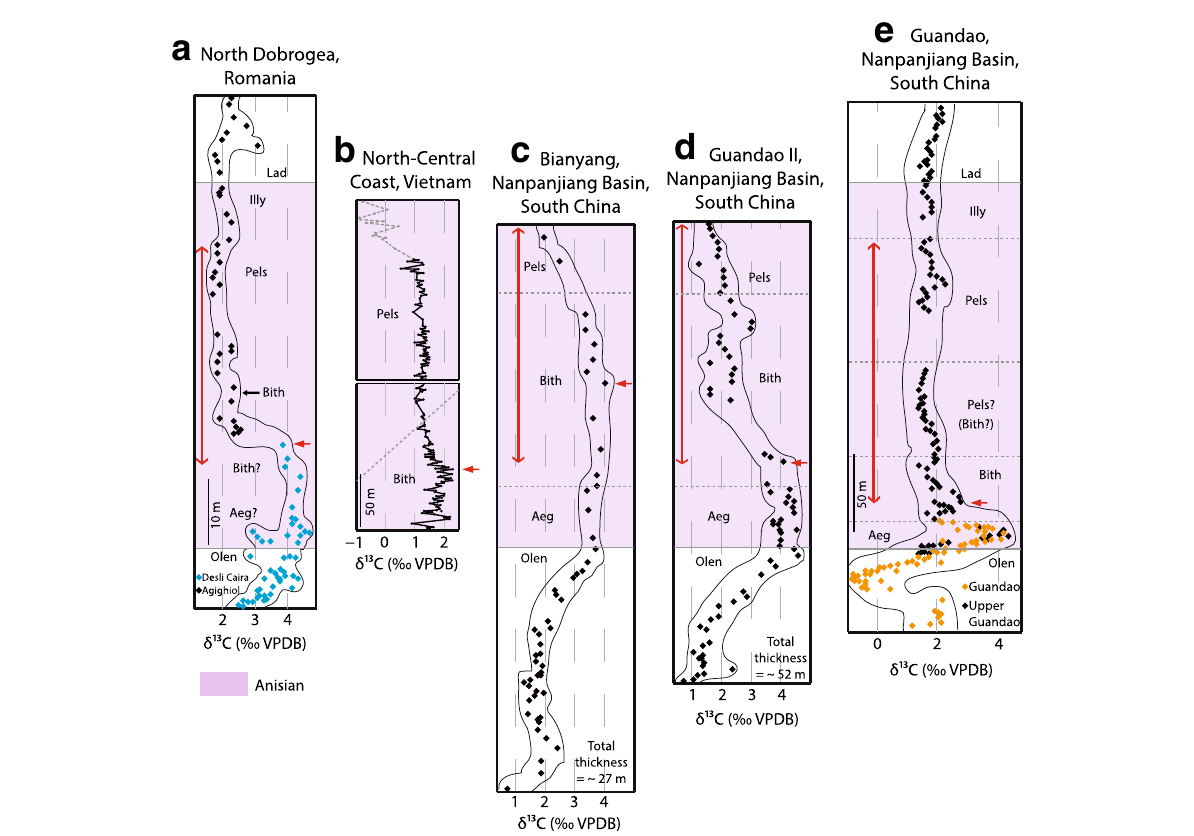
Fig. 8 Anisian δ 13 C profiles of carbonates from Romania, Vietnam, and South China. a North Dobrogea, Romania (Atudorei et al. 1997); b North-Central Coast region, Vietnam (this study); c Bianyang section, Nanpanjiang Basin, South China (Sun et al. 2012); d Guandao II section, Nanpanjiang Basin, South China (Sun et al. 2012); e Guandao section, Nanpanjiang Basin, South China (Payne et al. 2004). The vertical red double arrows indicate the interval represented by the studied carbonate succession in Vietnam. The small horizontal arrows indicate the basal horizon of the Bithynian δ 13 C decrease followed by the interval of prolonged (Bithynian – Pelsonian) stability or gradual decrease in values, as reported from South China and Romania. Abbreviations: Aeg, Aegean; Bith, Bithynian; Illy, Illyrian; Lad, Ladinian; Olen, Olenekian; Pels,